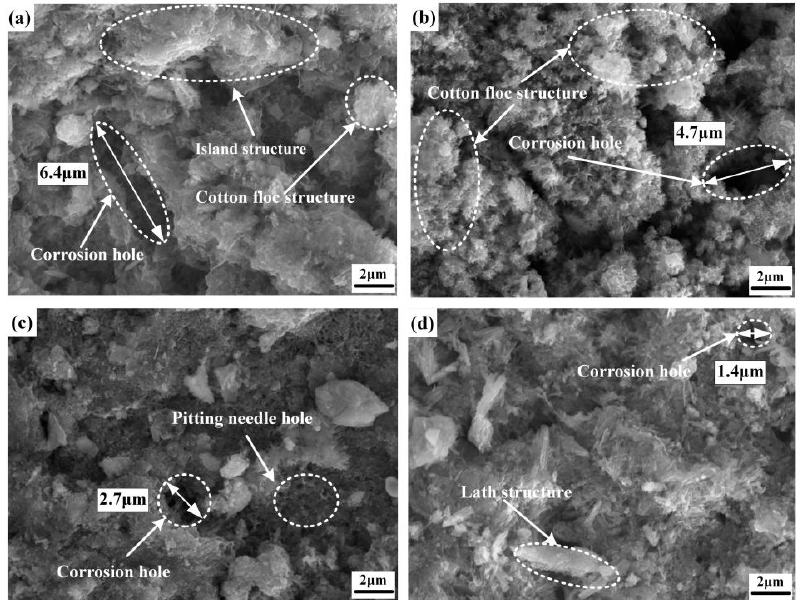
Figure 8. Micro-morphology of corrosion holes for each sample; ( a ) the micromorphology of corrosion holes for Sample polished; ( b ) the micromorphology of corrosion holes for Sample USP; ( c ) the micromorphology of corrosion holes for Sample DUSGP; ( d ) the micromorphology of corrosion holes for Sample WUSGP.